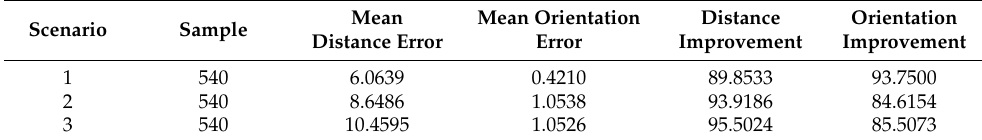
Table 4. Effect of distance on improving the position and orientation of the robot.